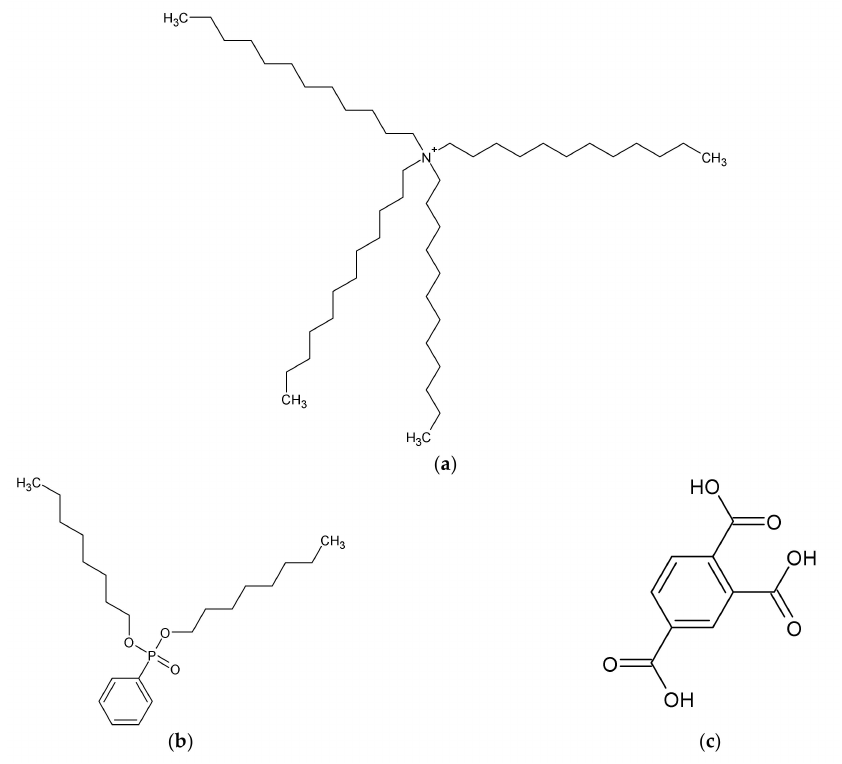
Figure 1. Structure of membrane components: ( a ) TDAB; ( b ) DOPP; ( c ) trimellitic